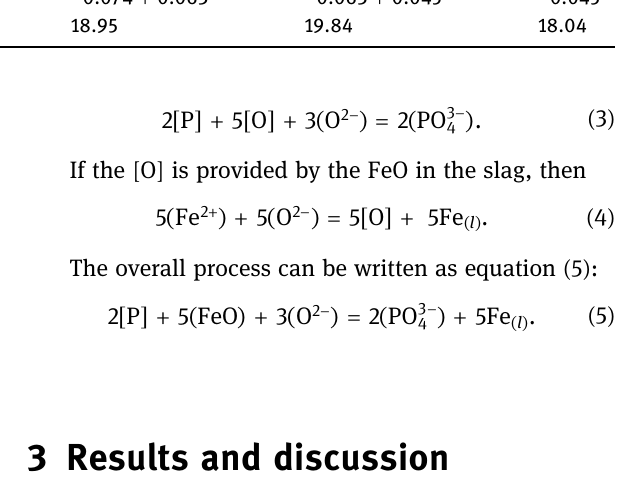
Size fraction ( mm )